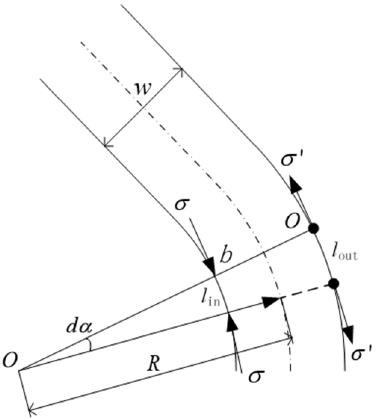
Figure 1. The curve curvature.